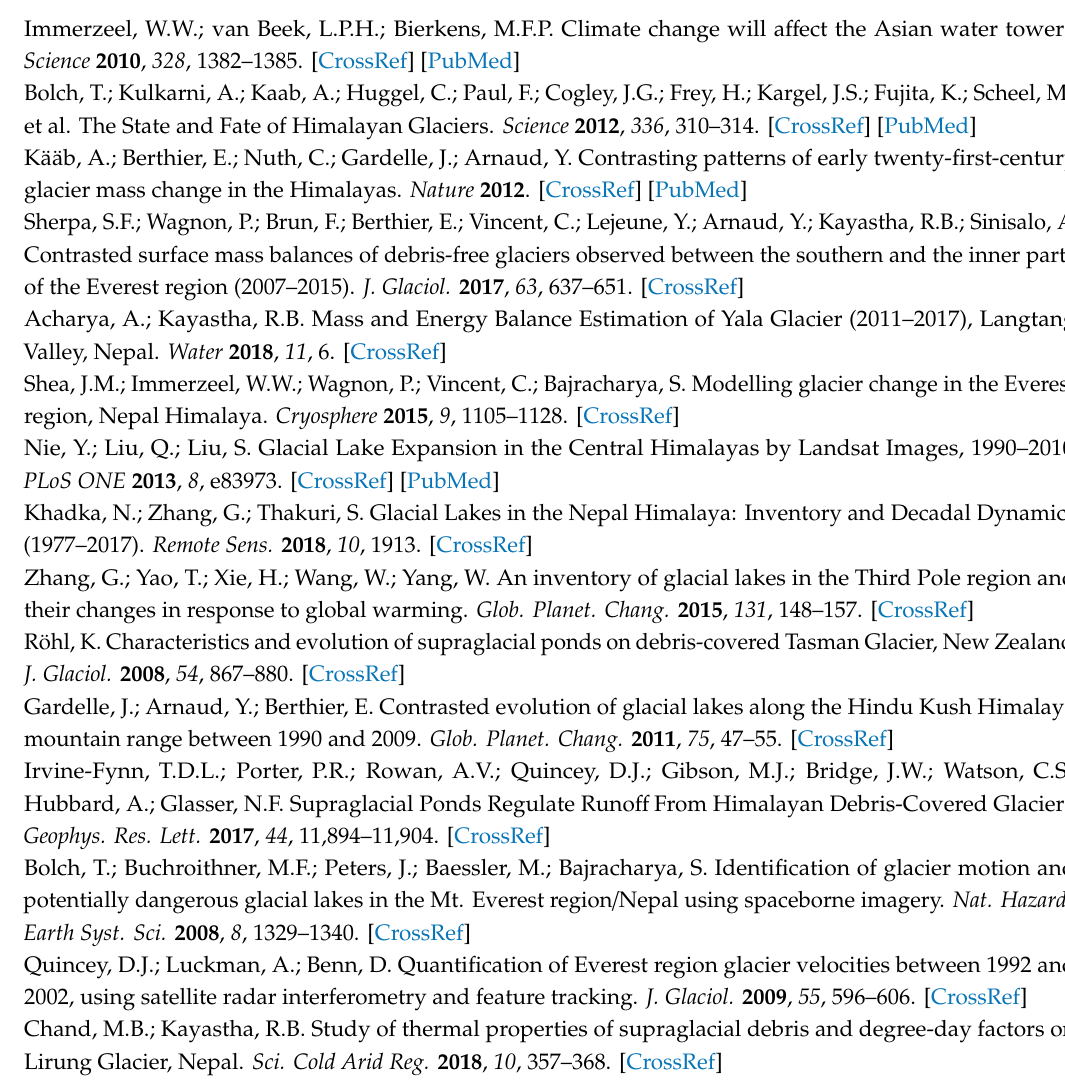
1058 / s1, Table S1: List of Landsat imagery used in the study, Table S2: List of Sentinel-2 imageries used in the study, Table S3: List of WorldView and GeoEye imageries used in the study, Table S4: Ponded area mapped using Landsat images from 1989–2017, Table S5: Number of ponds mapped using Landsat images from 1989–2017, Table S6: Fractional pond cover correspondence to debris-covered area obtained from Landsat images, Figure S1: Distribution of the supraglacial ponds on the 12 debris-covered glaciers showing the persistency of ponds from 1989–2017, and Figure S2: Examples of ponds obtained with the Landsat (a, d, & g), Sentinel-2 (b, e, & h), WorldView-2 (c & i), and GeoEye-1 (f) at the surface of the selected glaciers i.e., terminuses of Nuptse Glacier (a, b, & c), near terminus of the Ngozompa Glacier (d, e, & f), and terminus of the Melung Glacier (g, h, &